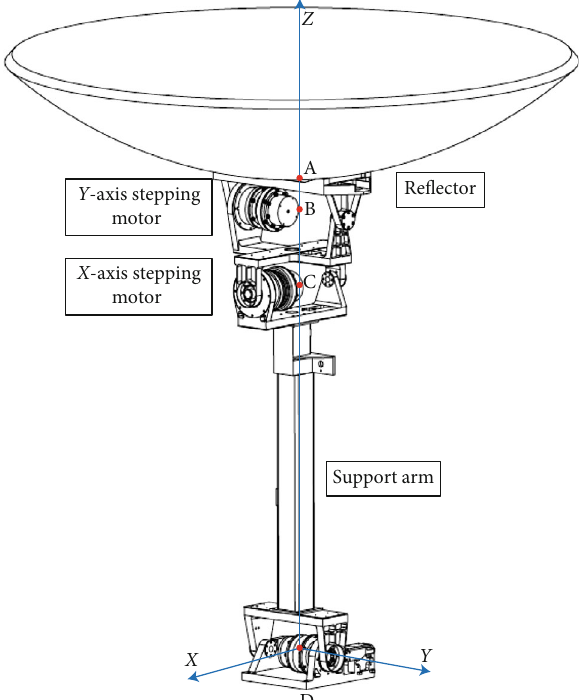
Figure 1: Structure diagram of dual-axis data transmission